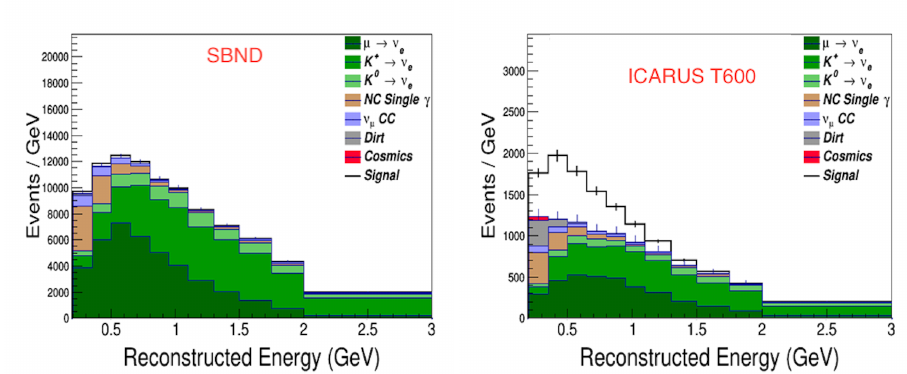
Figure 3. Expected ν e CC event distributions at the near SBND ( left ) and far ICARUS-T600 ( right ) detectors, corresponding to a 6.6 × 10 20 protons on target (POT) exposure at the Booster Neutrino Beam (BNB). The ν µ → ν e oscillation signal refers to ∆ m 2 = 0.43 eV 2 and sin 2 2 θ µ e = 0.013. The misidentified neutral-current and ν µ CC events, out-of-detector beam-related backgrounds, and cosmogenic photon-induced electromagnetic shower backgrounds are also included [21].